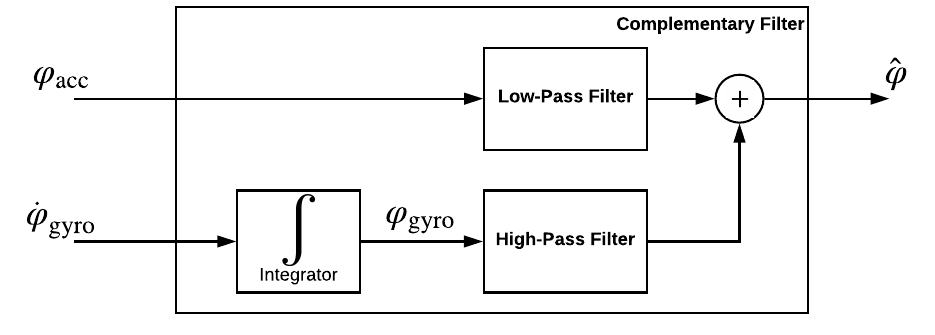
Figure 3. Complementary